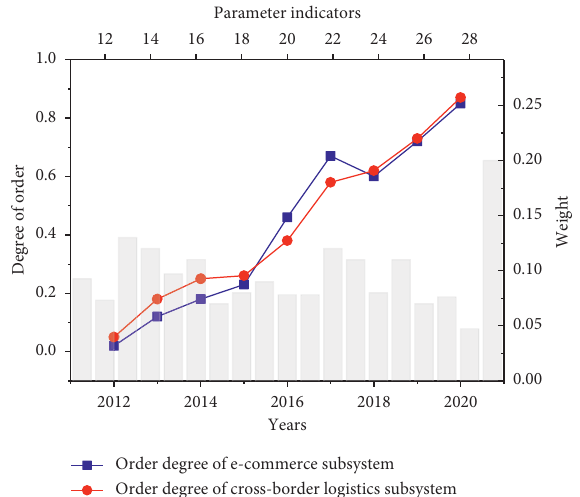
Figure 8: The index weight and order degree of cross-border e-commerce and logistics